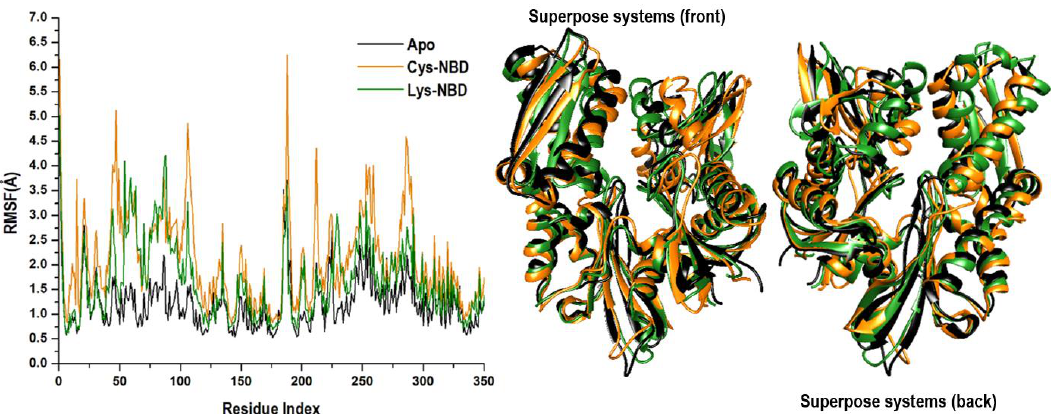
Figure 4. The time evolution RMSF of each residue of the protein C-α atoms over 250 ns for Apo (black color), and Cys-NBD (orange color), and Lys-NBD (green color). Superposed crystal structures of the